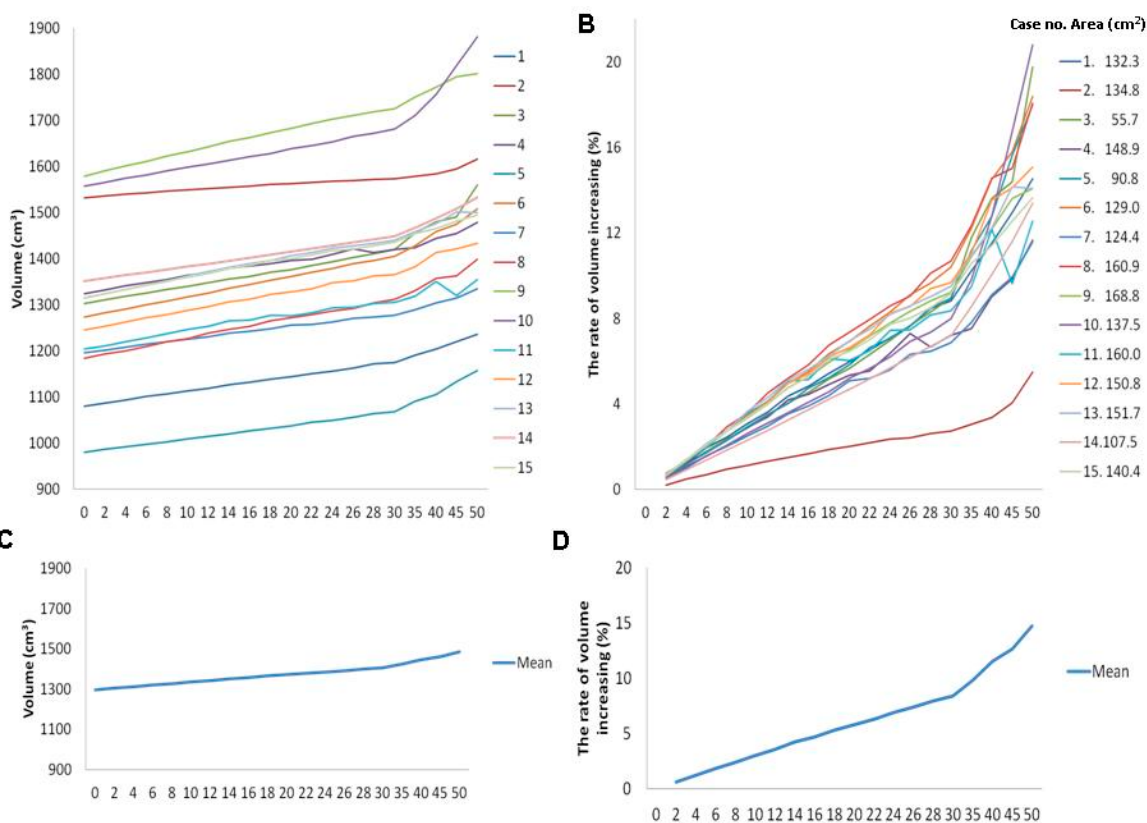
Figure 6. Individual profile of skull defect area ( right panel of B ) and plots for volume ( A ) and volume-increasing rate ( left panel of B ). Plots of mean profile for volume ( C ) and volume-increasing rate ( D ) in patients with contour elevation from 0 to 50 mm. Table 3. Parameter estimation of 15 CAD models: length of contour elevation as categorical data.